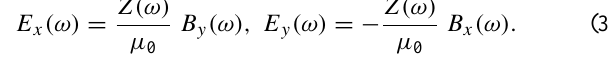
Fig. 2. Comparison of the ground magnetic (cid:2)eld and its time derivative calculated in a spherical (black line) and planar geometry (blue line). The ionospheric equivalent current system used as input for both cases was determined in the spherical geometry. The effect of the conducting earth is ignored.